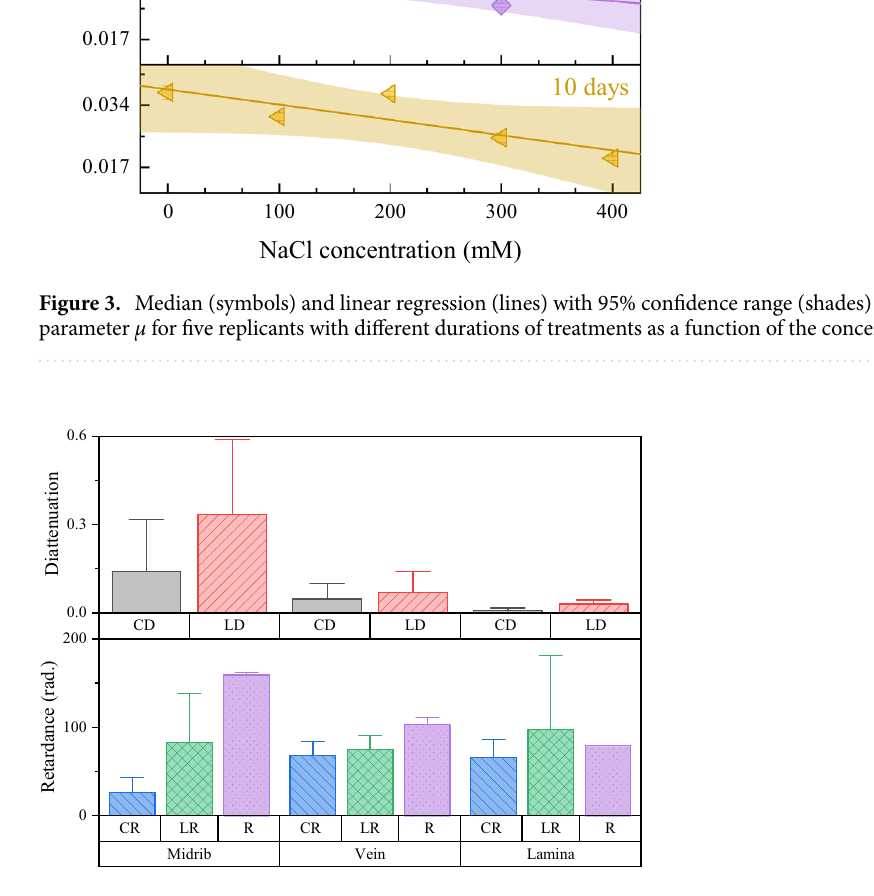
Figure 4. Polarization components obtained from a Mueller matrix of a lettuce leaf, where CD and LD are the circular and linear diattenuations, CR and LR are circular and linear retardances and R is the total